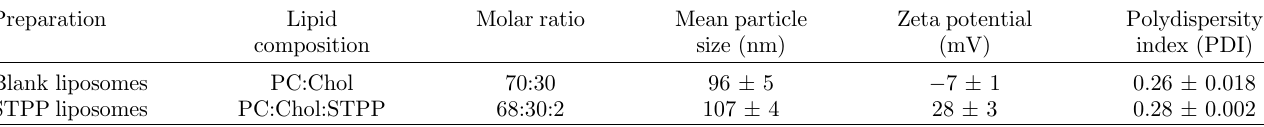
Table 1. Physical characterization of liposomal preparations.